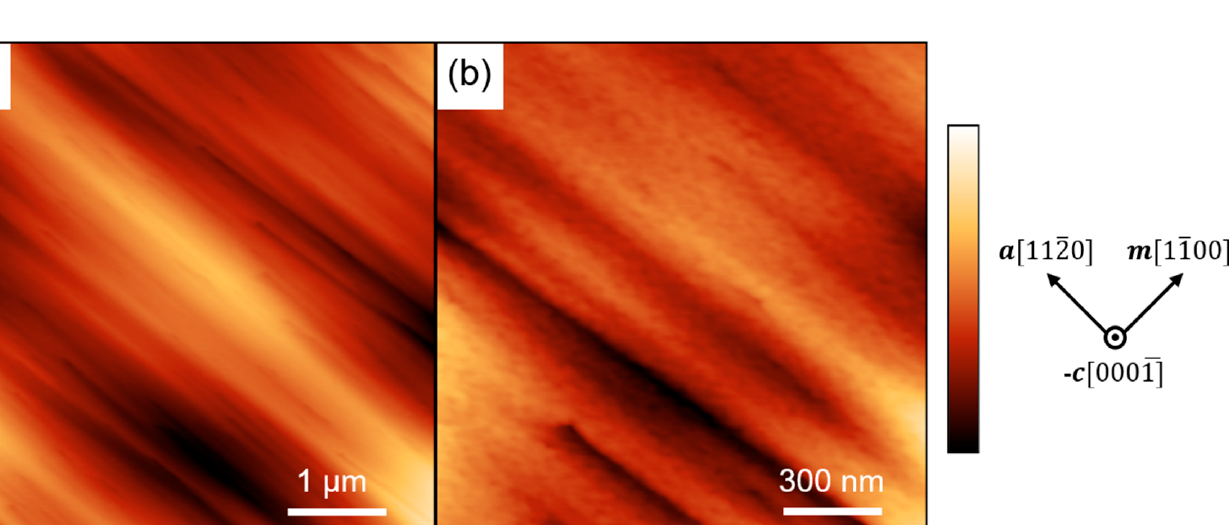
Figure 1. Epitaxial structure of uncapped N − polar InN samples.